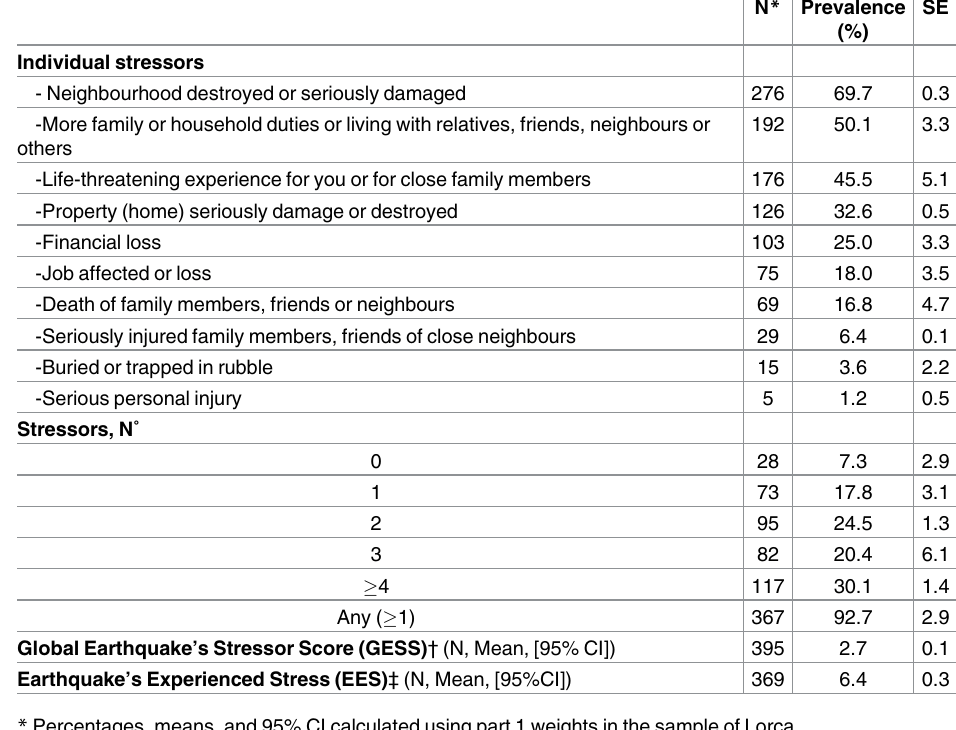
Table 2. Descriptive statistics for earthquake-related stressorsin Lorca’s subsample (n = 412).